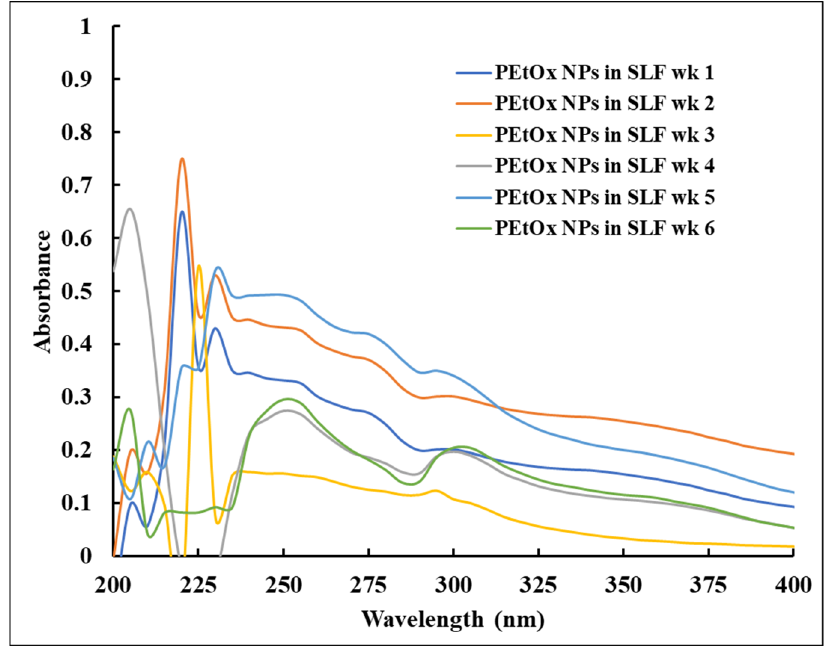
Figure 15. UV–Vis spectra of PEtOx NPs at different time intervals incubated in SLF. SLF was used as the reference.